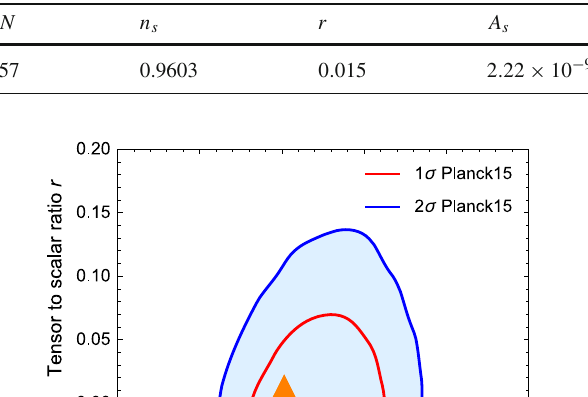
Table 2 The theoretical predictions for ρ ∗ = 0 . 055 and ρ end = 0 . 403 and the parameters given in Fig. 5